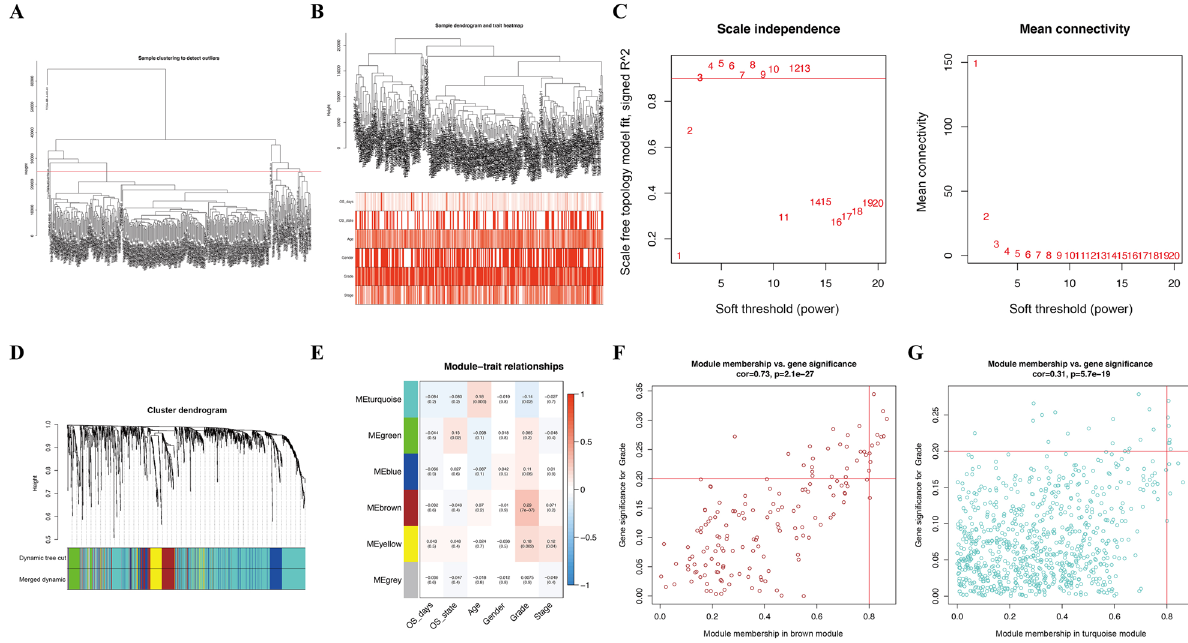
Figure 9. WGCNA analysis. ( A ) Samples clustering of OS genes from TCGA database to detect outliers. (B) Clustering dendrogram of GC samples and associated clinical traits. ( C ) The scale-free fit index for soft- thresholding powers. ( D ) A dendrogram of the differentially expressed genes clustered based on different metrics. ( E ) A heatmap showing the correlation between the gene module and clinical traits. Scatter plot of module eigengenes in brown ( F ) and turquoise ( G )